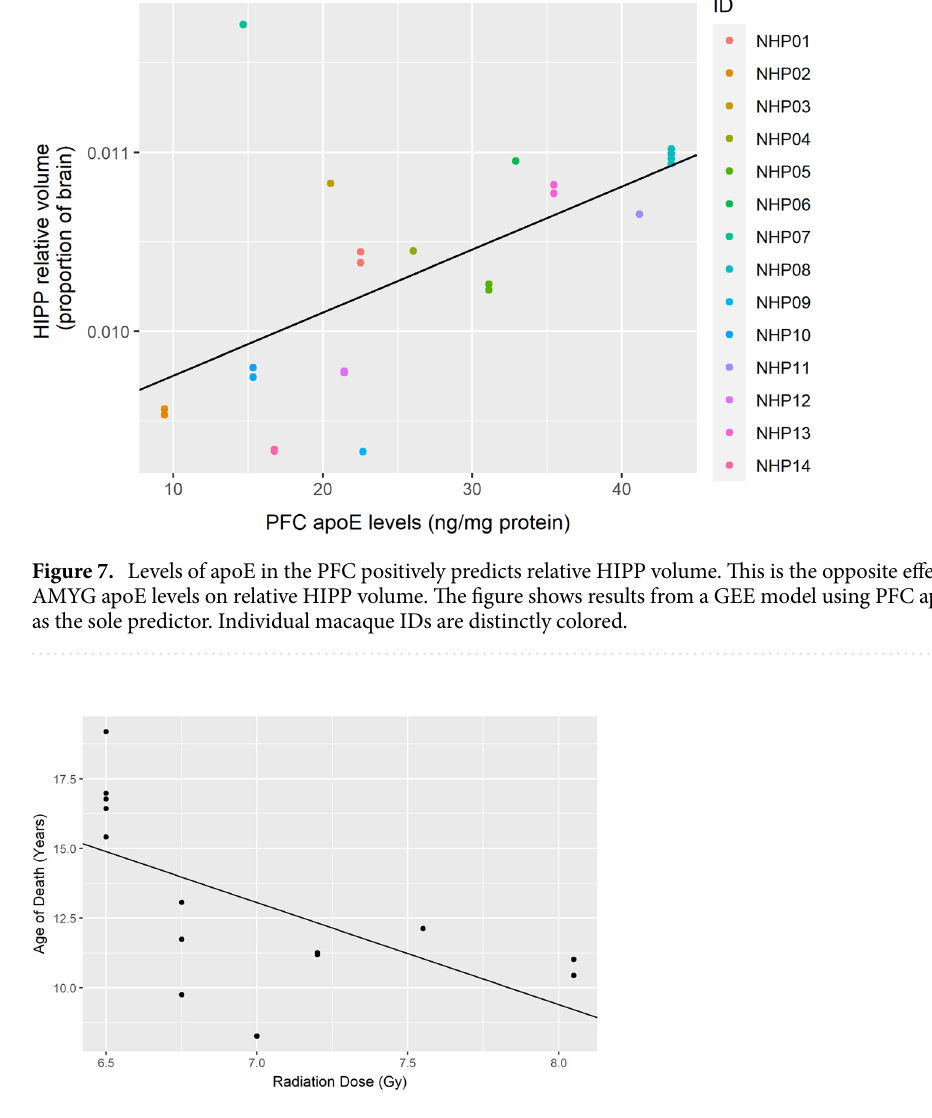
Figure 8. Larger dosages of radiation predict a younger age at